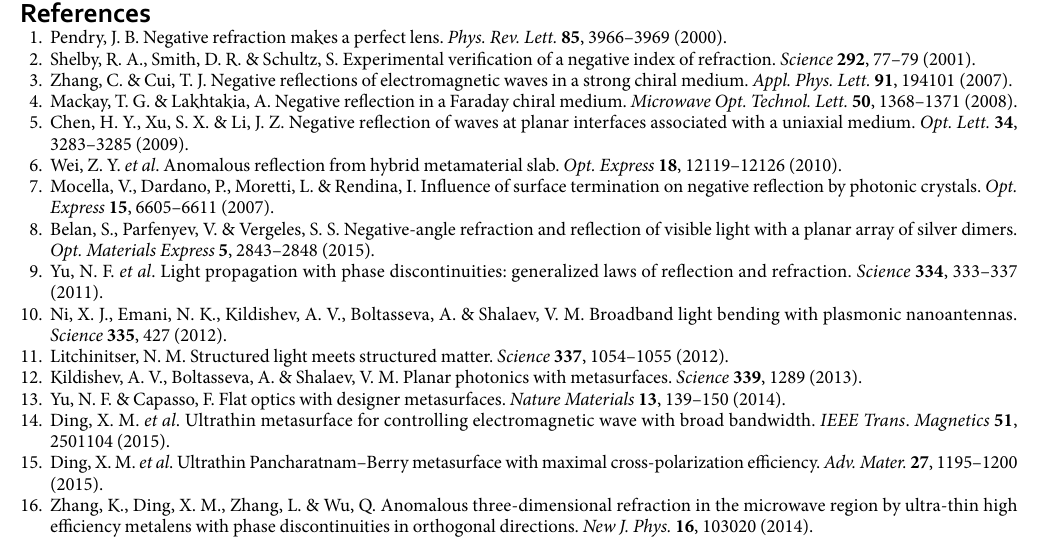
performances shown from the experiments of the dual reflecting system still fulfill our initial design of the nega- tive reflecting meta-mirrors, and further verify the functionalities of the dual reflecting system to obtain the plane wave from the convex meta-mirror firstly and then have the well collimated beam negative reflected by the planar meta-mirror. In conclusion, we have proposed negative reflecting meta-mirrors in this paper and demonstrated that the incident wave can be reflected anomalously with a broad angle range of negative reflections. Applications for the planar meta-mirrors and the convex meta-mirrors are both demonstrated and practically implemented through a periodic arrangement of the subwavelength ring patches, where the impacts of the oblique incident angles have also been considered when generating the desired phase distributions. Finally, we carried out the exper- iments to verify the functionalities of the convex meta-mirror and the planar meta-mirror. Especially, we have further built up a dual reflector system with the demonstration of obtaining the plane wave from the convex meta-mirror and then having the well collimated beam negative reflected by the planar meta-mirror. We expect the proposed design of the negative reflecting meta-mirrors would be applicable to electromagnetic problems in relative research fields, especially for devising smart planar illusion devices, and highly directive antennas mount- ing on convex surfaces of various platforms.